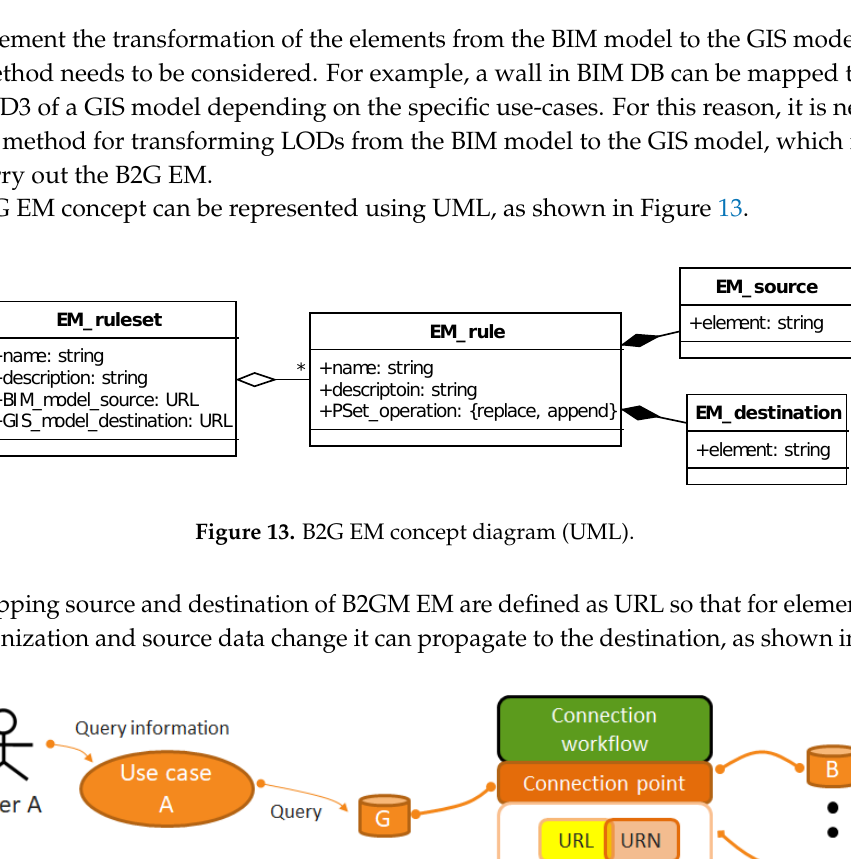
Figure 12. B2G EM-based element transform concept and relationship between B2GM EM and B2G LM (e.g., dictionary model such as RDBMS).